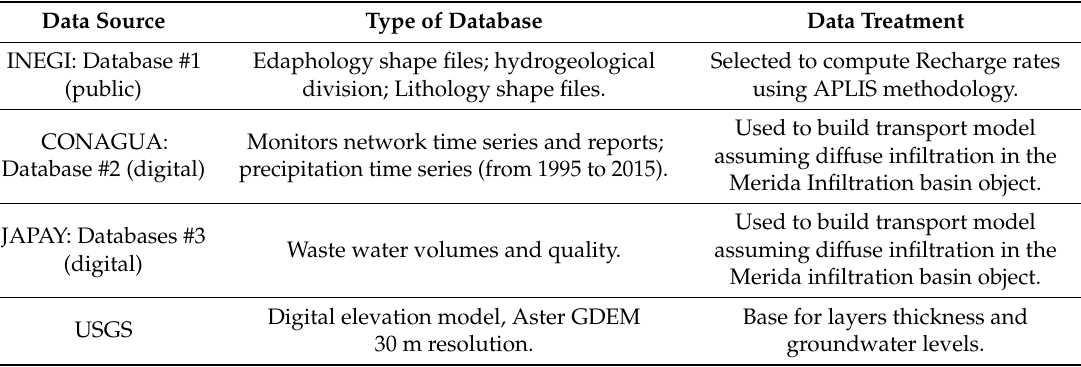
Table 1. Available public data bases used to build the Yucatan